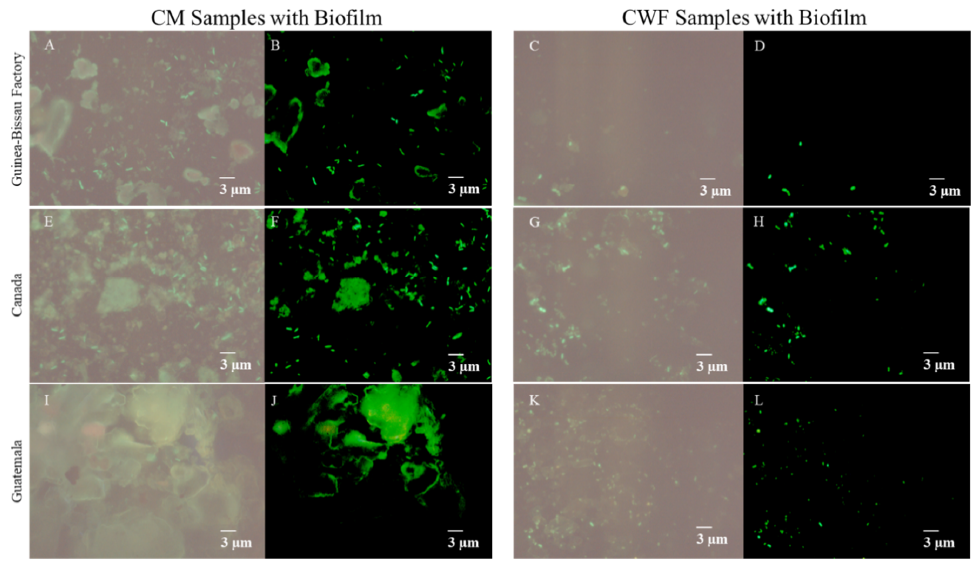
Figure 1. Biofilm growth on CM and CWF samples. CM and CWF samples from Guinea Bissau Factory ( A – D ); Canada ( E – H ); and Guatemala ( I – L ) were analyzed for their effect on biofilm growth. Each set of CM and CWF samples was analyzed with two channels on the microscope: the bacterial-specific channel (channel 1) and clay-specific channel (channel 2). The images in the left-hand columns of the CM and CWF sets were analyzed using channel 2 (Images A , C , E , G , I , and K ), and the right-hand columns are images from channel 1 (Images B , D , F , H , J , and L ). The green areas indicate bacterial growth. Positive and negative controls can be found in Figure S3. Water 2020 , 12 , x FOR PEER REVIEW